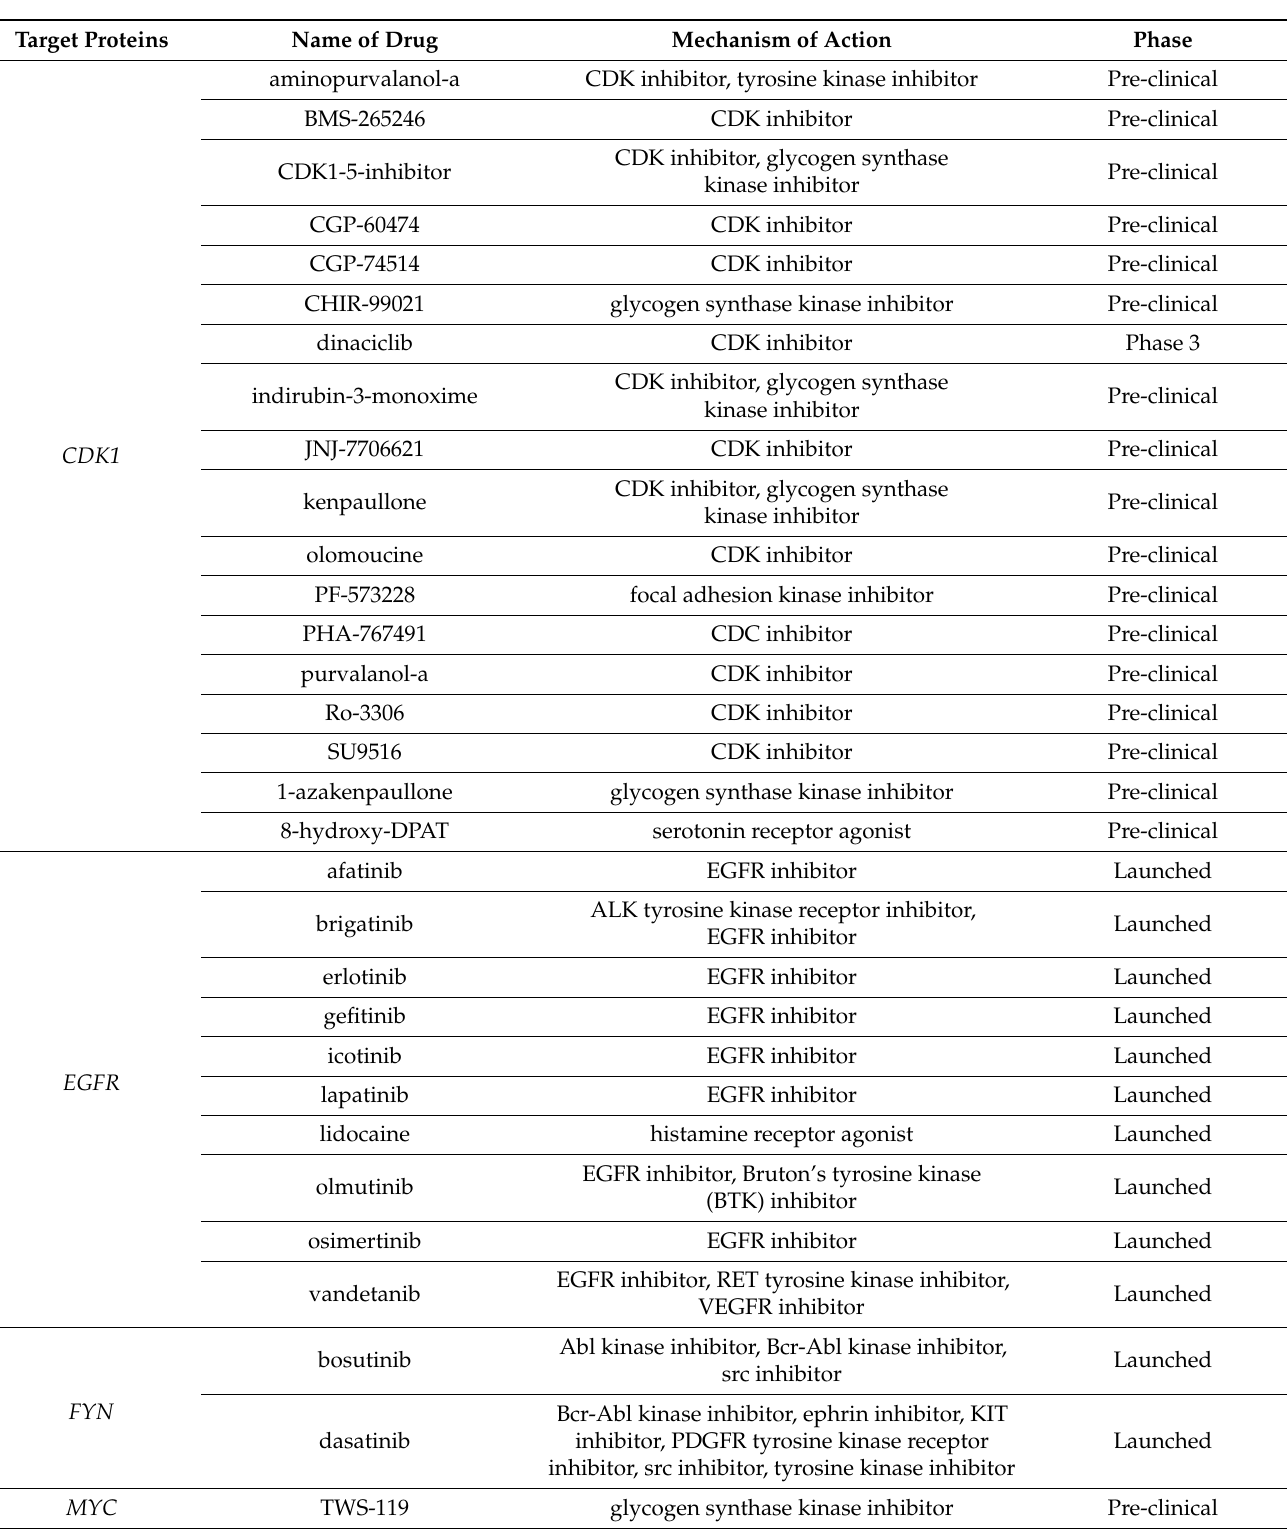
Table 3. The repurposed drugs that were found from the CMap